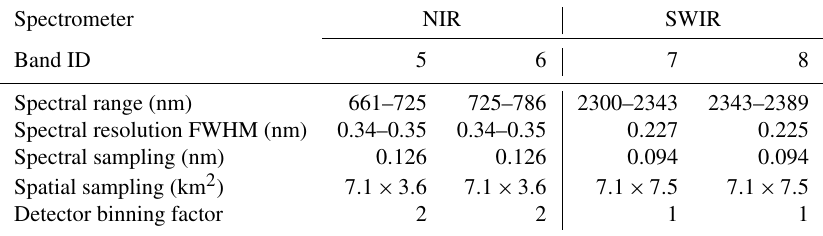
Table 1. Summary of the TROPOMI NIR and SWIR spectral bands and their key features (Rozemeijer and Kleipool,